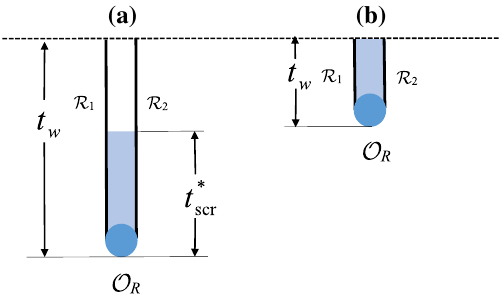
Fig. 2 A representation of the insertion of a perturbed operator O R at the time − t w for the TFD state at t R = t L = 0, in analogy to